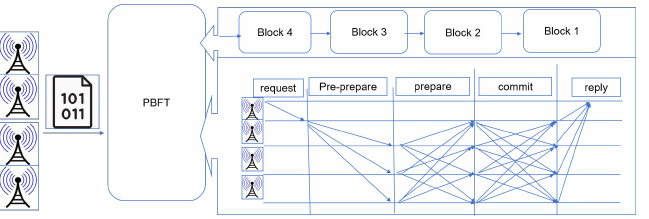
Figure 4. PBFT consensus process.